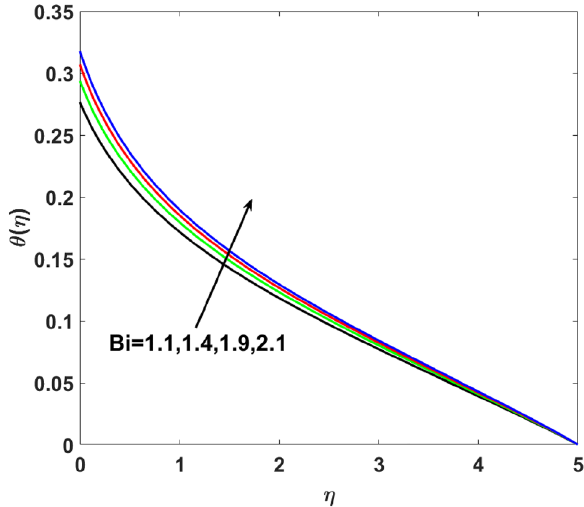
Figure 12. θ(η) versus Bi .